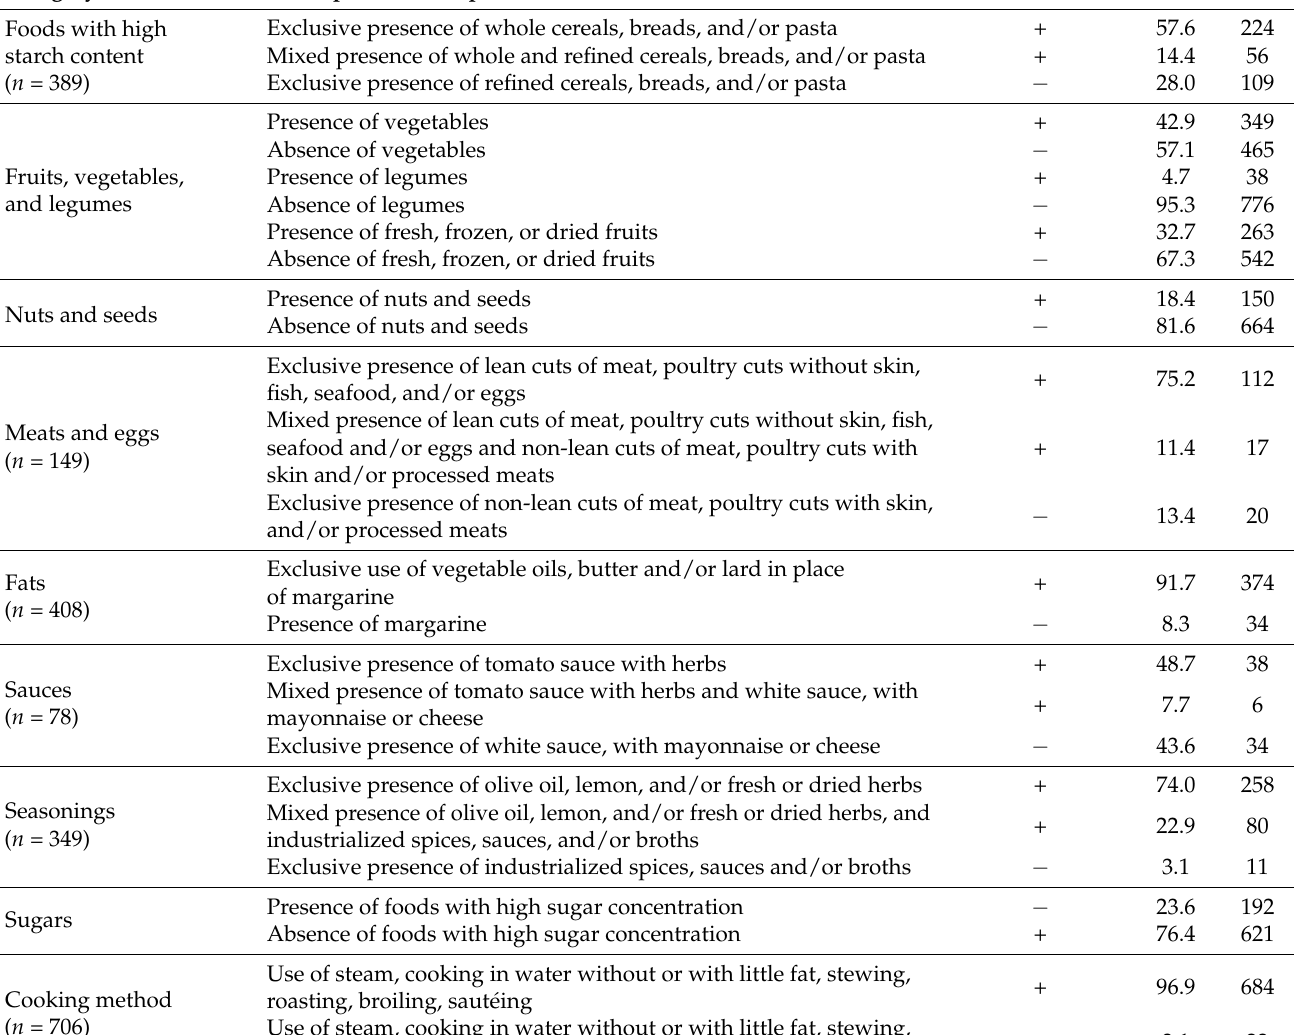
Table 2. Healthiness of 814 culinary recipes available on the ‘healthy eating’ section of a popular Brazilian recipe-sharing website according to the Qualitative Framework for the Assessment of Culinary Recipes’ Healthiness, October 2019–March